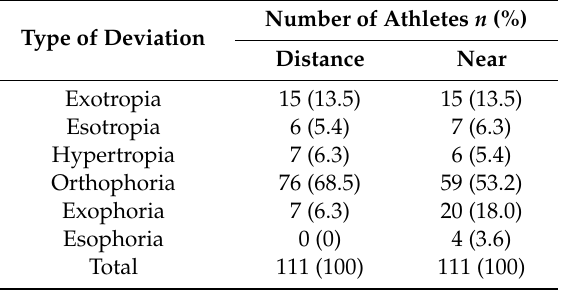
Table 5. Cover test results at two testing